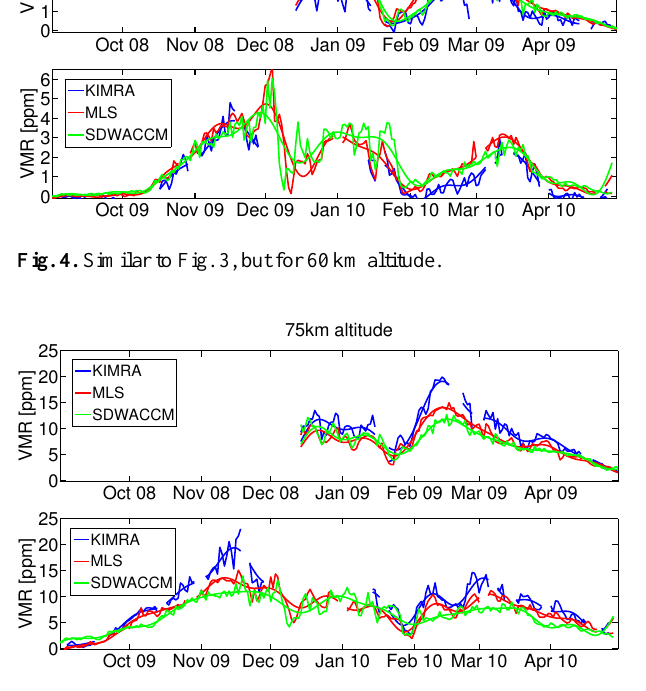
higher vertical resolution, we have verified that the MLS- SDWACCM correlation exhibits a similar behavior (Fig. 7) when the MLS and SDWACCM profiles are not convolved with the KIMRA AVK. Note, however, that the most pre- cise direct comparison with MLS requires convolving the